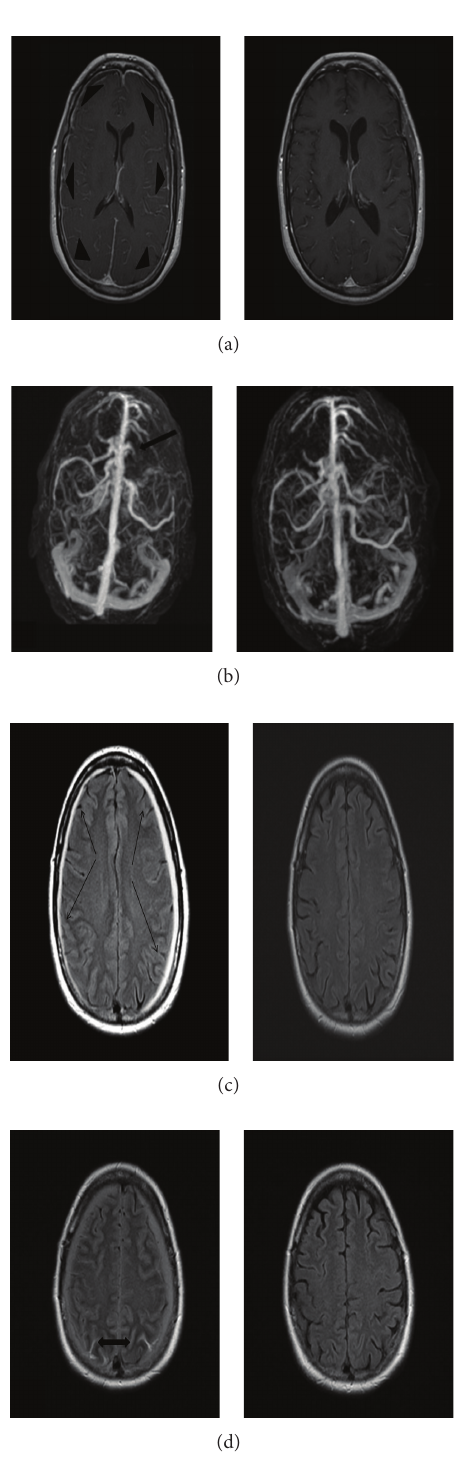
Figure 2: Right side (pretreatment) and left side (posttreatment). Axial T1 weighted magnetic resonance imaging (MRI) after intra- venous administration of gadolinium. (a) Brain showing resolution of the pachymeningeal enhancement (arrow heads); (b) magnetic resonance venogram showing occlusion of the left cortical vein (arrow). Axial fluid attenuated inversion recovery MRI brain (c) showing resolution of subdural hematomas (arrows) on the bilateral convexities; subarachnoid hemorrhages (d) in the bilateral parietal lobes (bidirectional